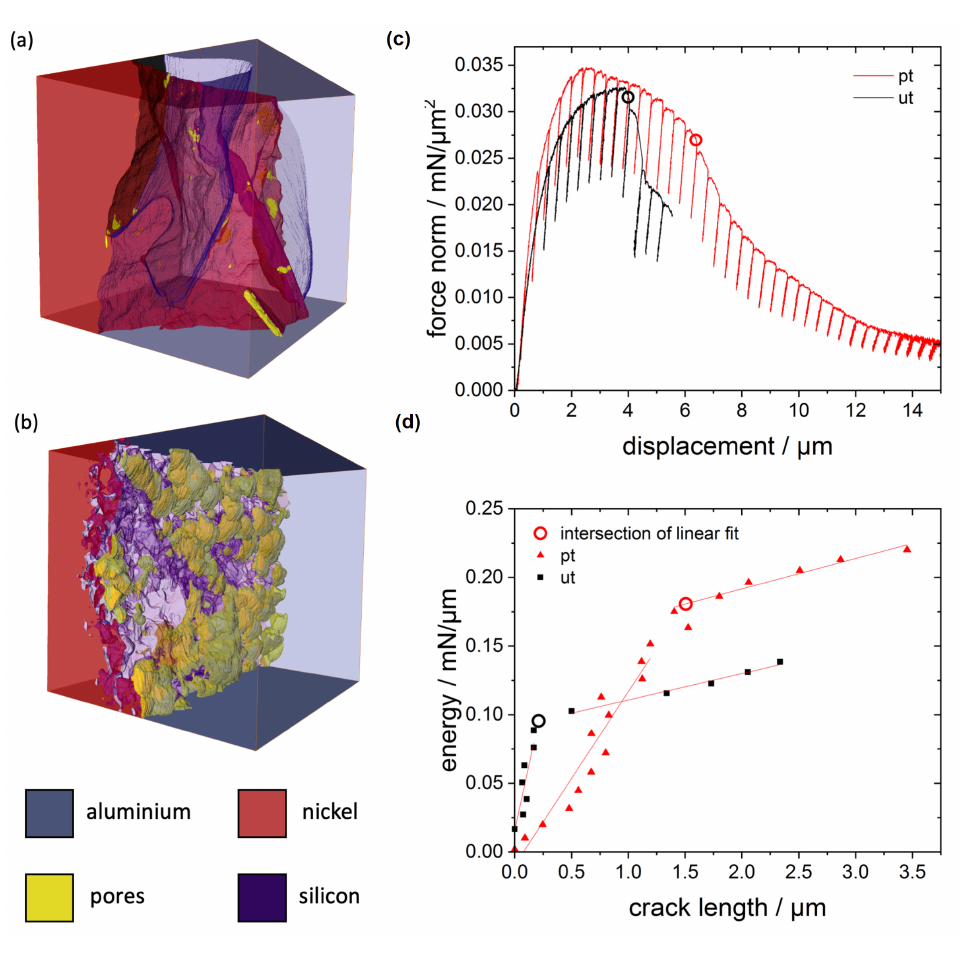
Figure 6. Results of the FIB-based evaluation methods: A visual comparison of the interface morphology of ( a ) an untreated sample and ( b ) a pre-treated sample from FIB tomography 3D reconstruction. Each volume is 8 × 8 × 8 µ m 3 . On the right-hand side the results of the microbending experiments from a pre- treated (pt) and untreated (ut) specimen. ( c ) displacement vs normalized force with partial unloading segments. ( d ) Absorbed energy contrasted to the evolving crack length. (images adapted from